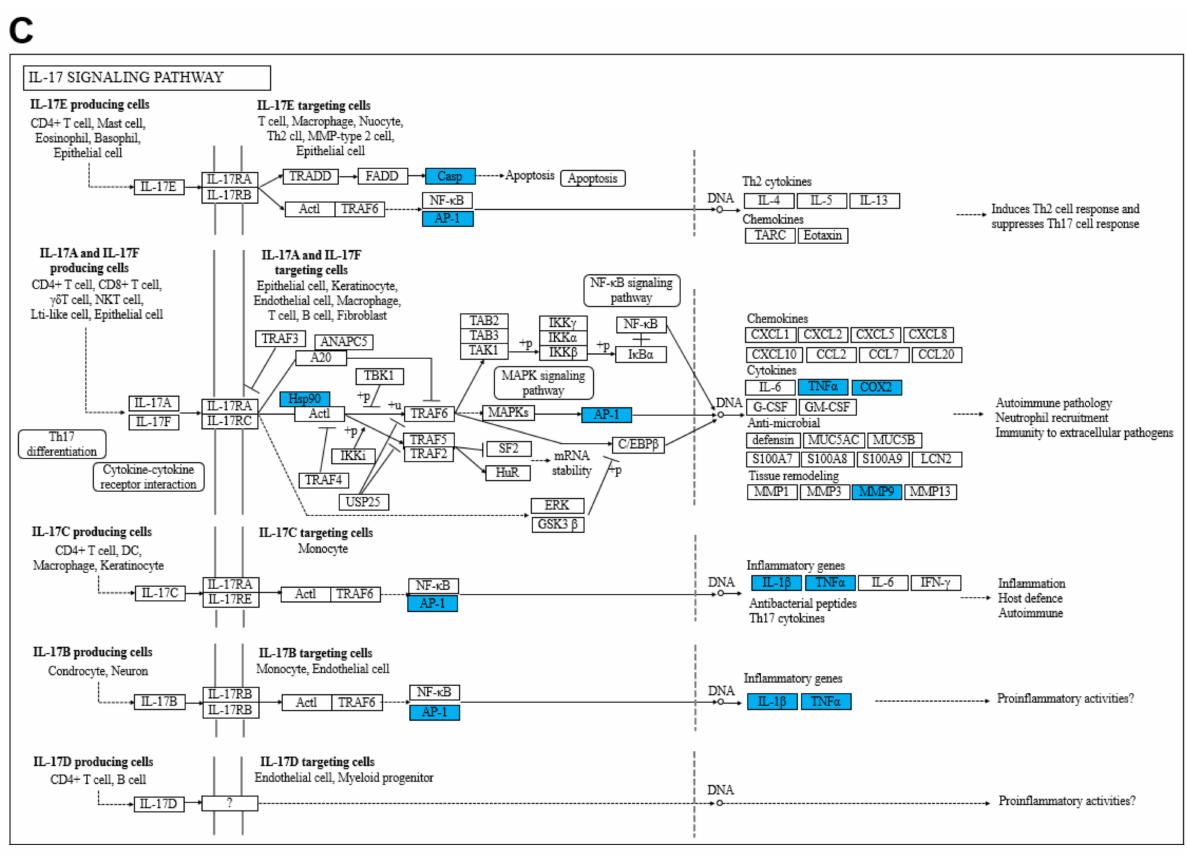
Figure 5. GO and KEGG enrichment analysis. ( A ) Bubble plot of GO enrichment analysis. ( B ) Bubble plot of KEGG pathway enrichment analysis. ( C ) IL-17 signaling pathway was constructed using the KEGG mapper. Blue represents the potential targets of the RPE